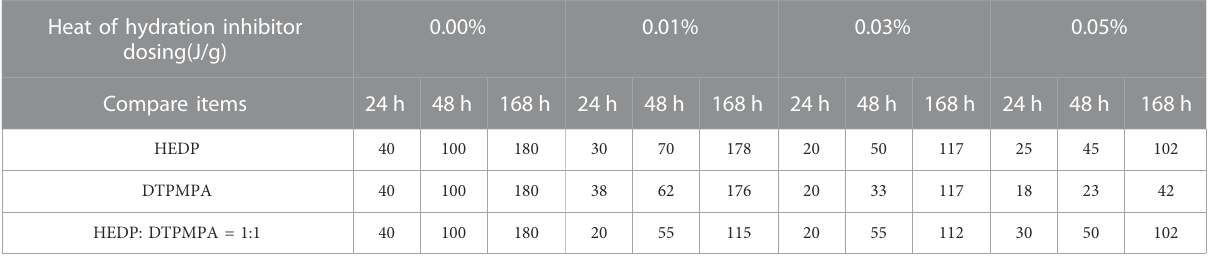
TABLE 10 Cumulative hydration heat release data of OPC over various periods. Heat of hydration inhibitor